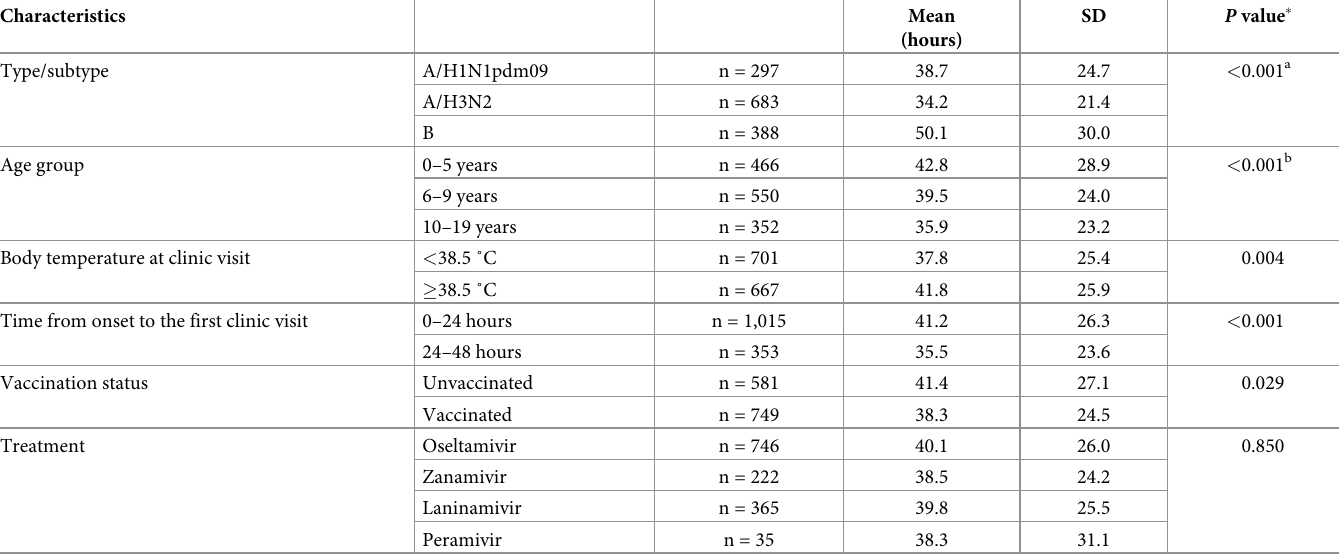
Table 3. Univariate analyses of the mean fever duration after NAI treatment, according to different characteristics.